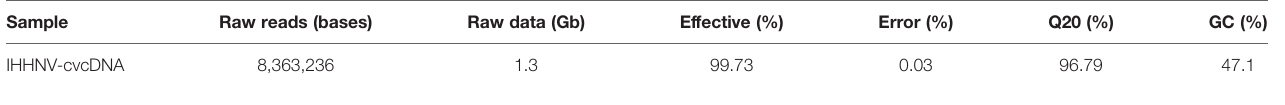
TABLE 2 | Sequencing information from the cvcDNA preparation obtained using the Illumina sequencing platform. Sample